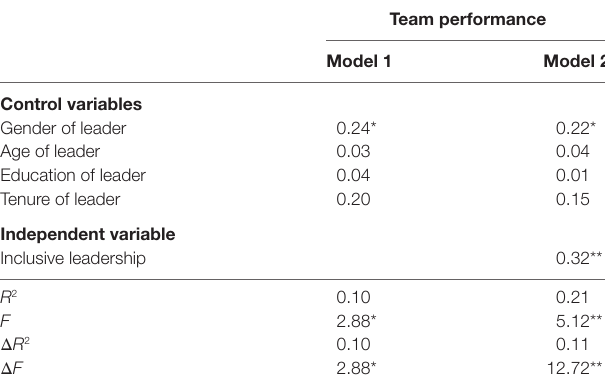
TaBle 3 | Results of regression analysis between inclusive leadership and team